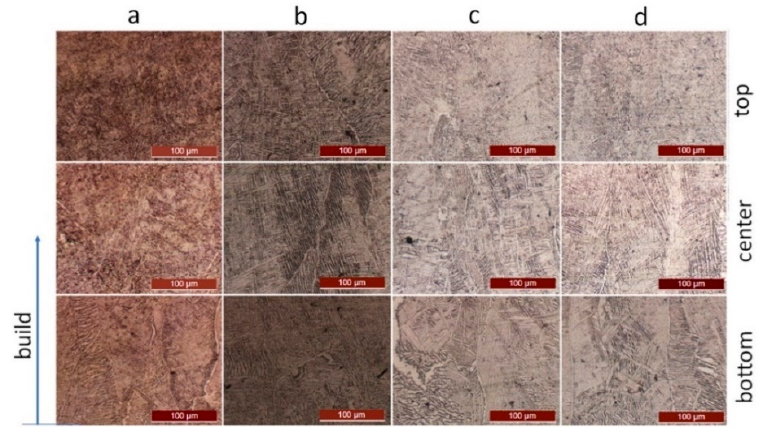
Figure 6. Collective set of optical images of microstructures (Kroll etchings) in the a–d samples as a function of the build distance from the build plate to the last deposited layer (bottom, center, and top) at 100×.